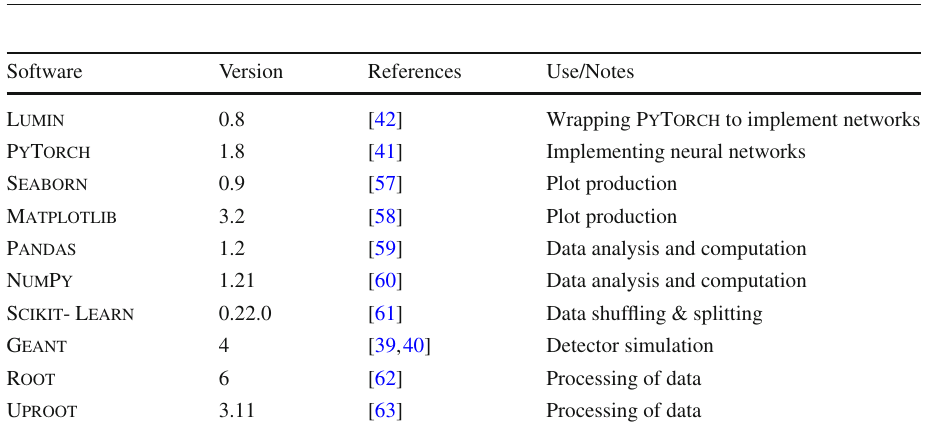
Table 4 Ablation study of the architecture. The change in MI is computed as the fractional difference with respect to the default model. “Parameters” refers to the number of trainable parameters in the architecture of each model